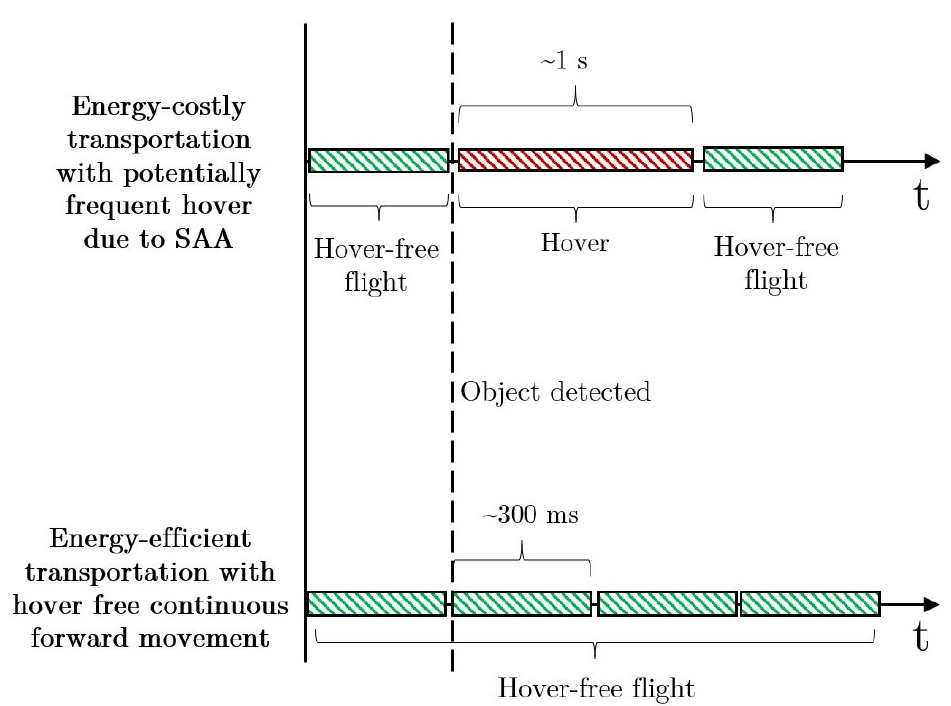
Figure 7. Flight profile